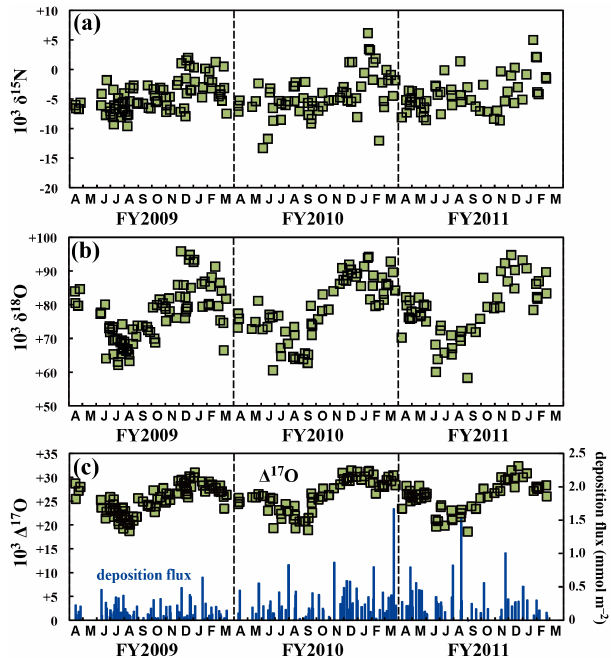
Figure 3. Temporal variations in the values of (a) δ 15 N, (b) δ 18 O, and (c) (cid:49) 17 O of nitrate in wet deposition recorded at the Sado-seki National Acid Rain Monitoring Station. The errors were smaller than the sizes of the symbols. The daily depositional flux of nitrate when each of the wet deposition samples was taken is also pre- sented (c) .